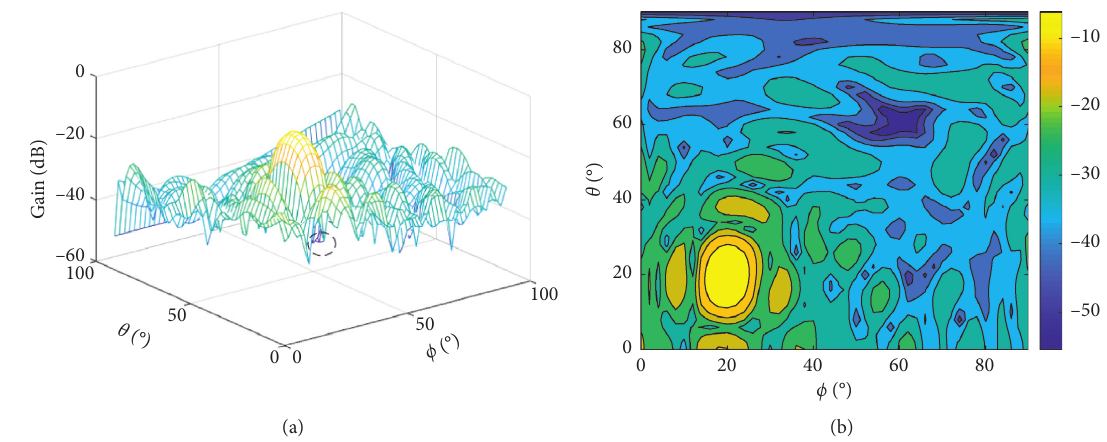
Figure 10: Beampattern produced by MODE. (a) The 3D polarized beampattern. (b) The contour of polarized beampattern.